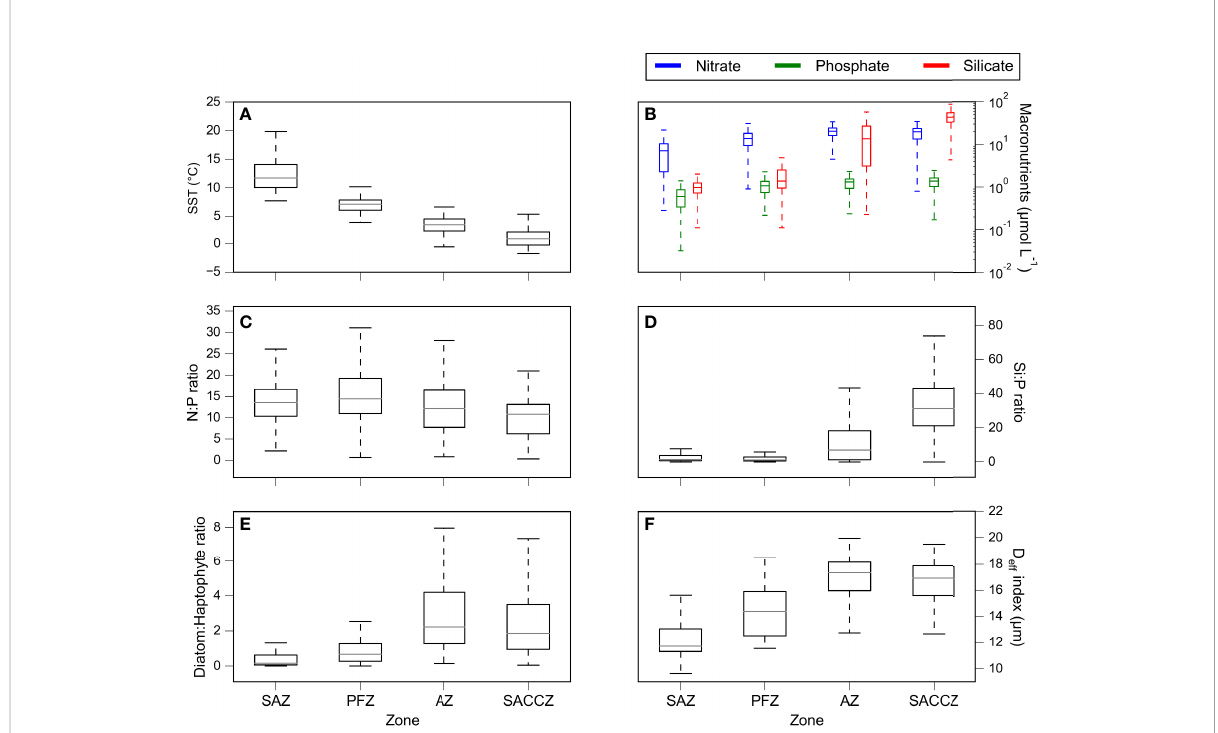
FIGURE 5 Ancillary parameters grouped per zone across all cruises for (A) Surface seawater temperature (SST) (°C), (B) Macronutrient concentrations (µmol L -1 ) plotted on a logarithmic scale, (C) Nitrate:Phosphate (N:P) (mol:mol) and (D) Silicate:Phosphate (Si:P) (mol:mol), (E) Diatom: Haptophyte ratio (% contribution to Chl-a) and (F) the phytoplankton effective diameter (D eff ) index (µm). Boxplots represented as 25th and 75th percentile with median. Error bars represent standard